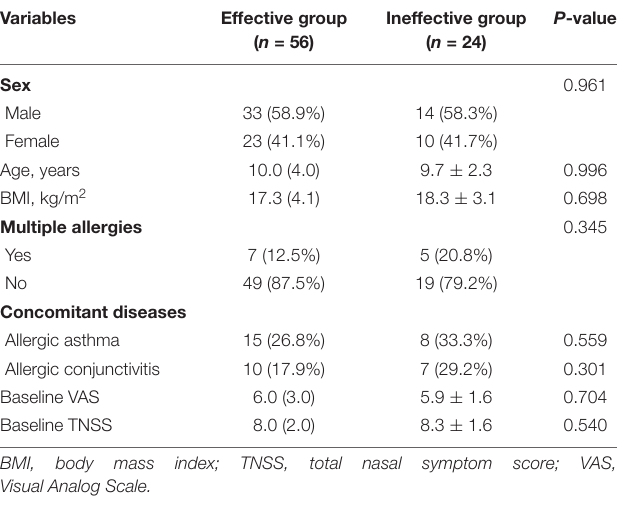
TABLE 1 | Demographics and clinical characteristics of patients in discovery cohort.